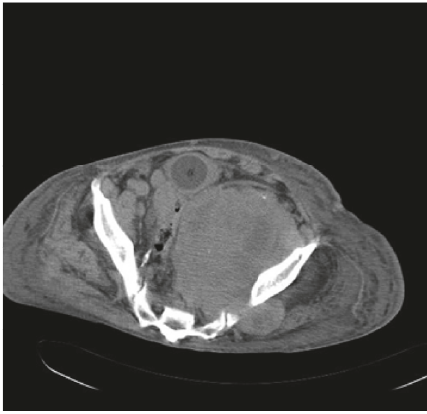
Figure 2: CT of abdomen and pelvis shows the retroperitoneal masses.